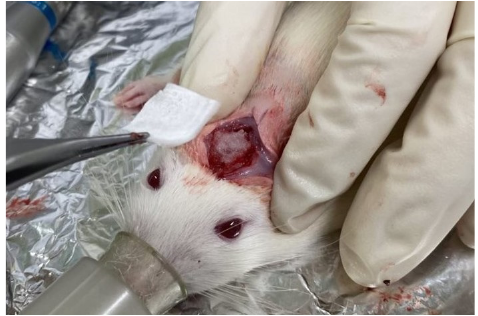
Figure 2. Photograph of the prepared construct granules in a rat cranial bone defect and the covering collagenous membrane.